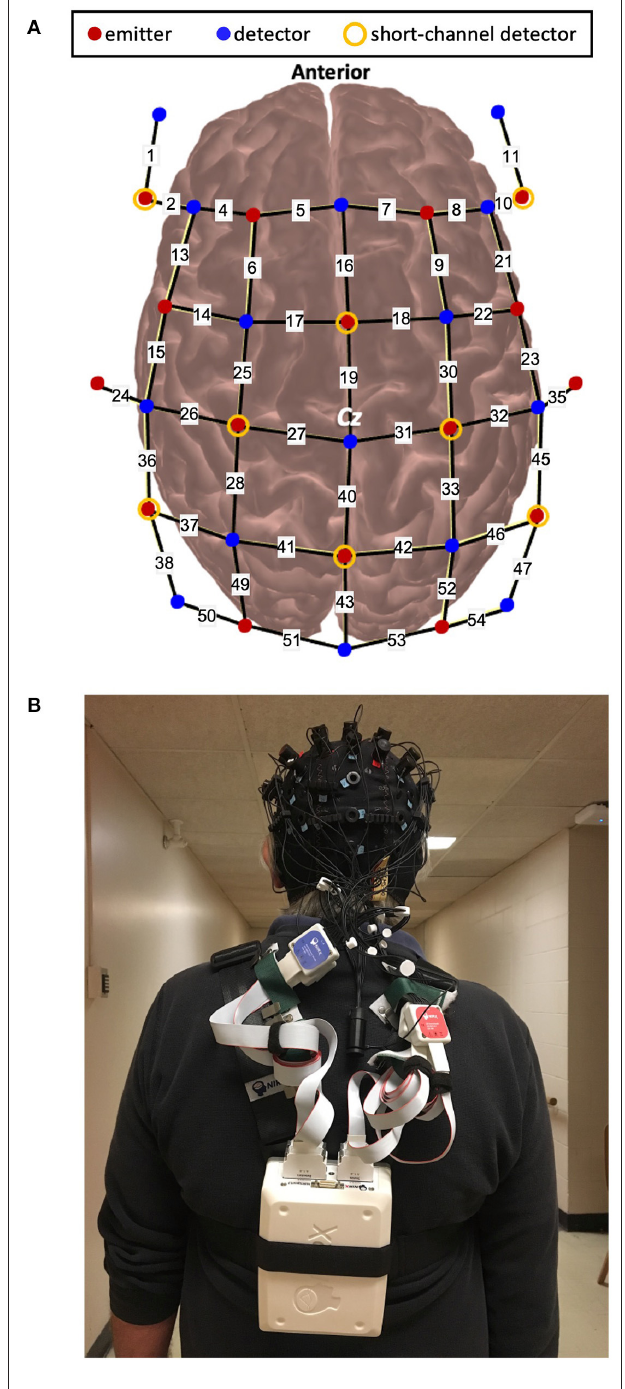
FIGURE 1 | (A) . Schematic of optode configuration and (B) . Example of a participant wearing the fNIRS device.